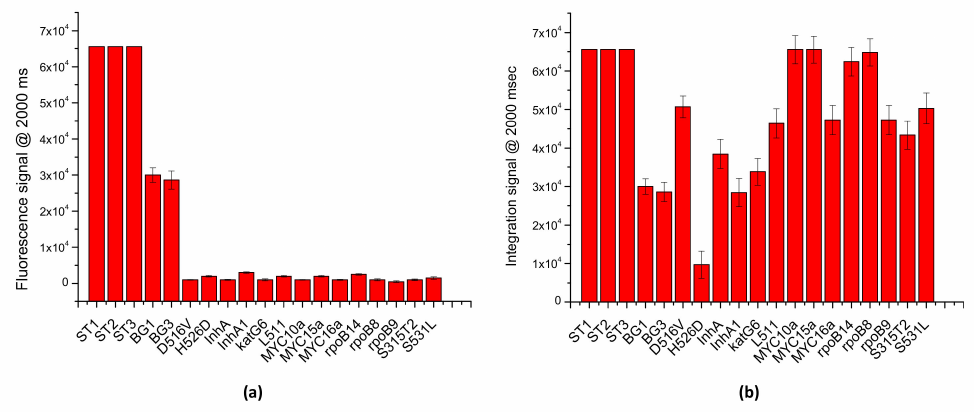
Figure 7. LoCs-MA integrated experiments: ( a ) specificity tests; ( b ) multiplexing